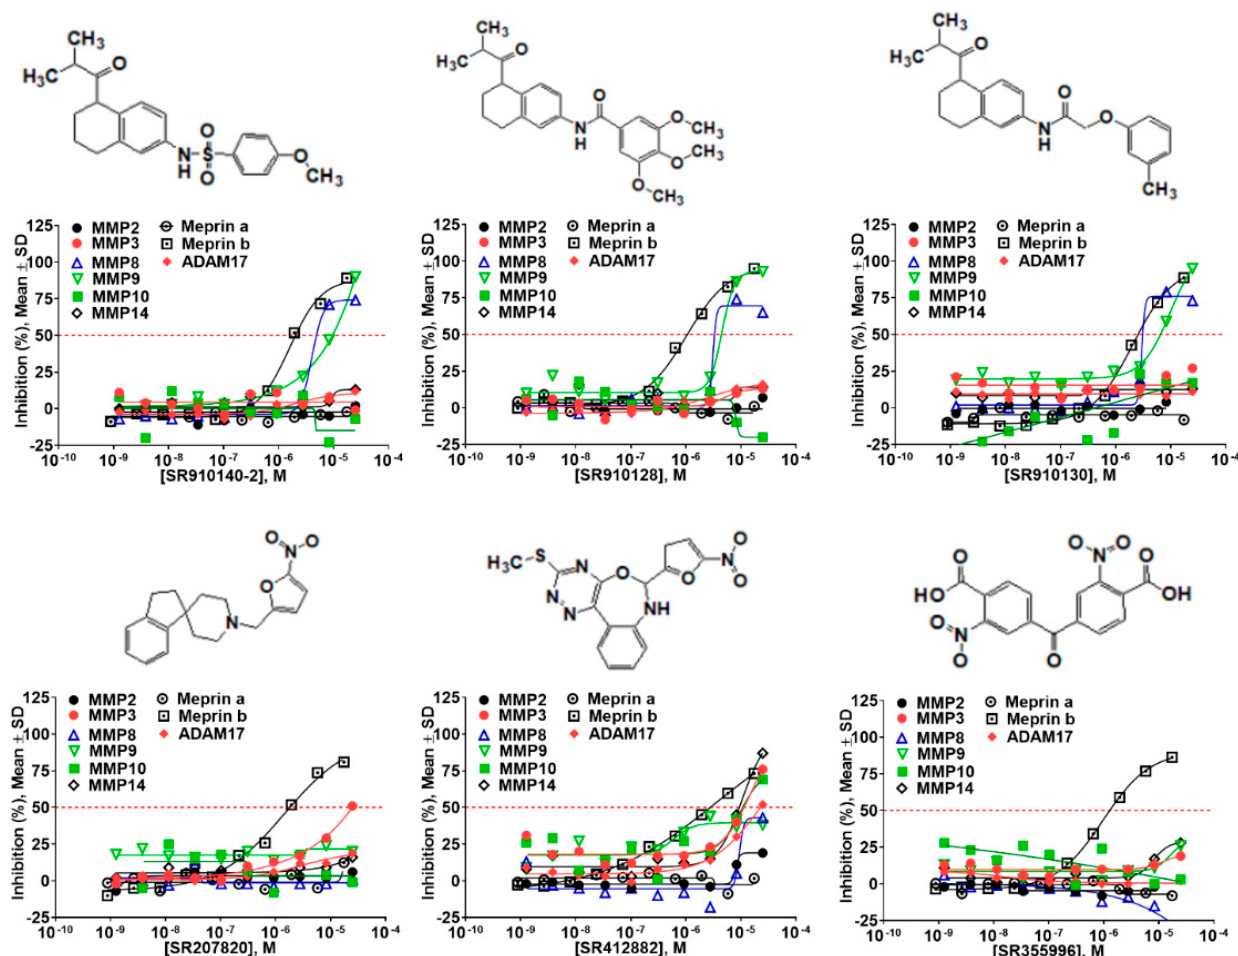
Figure 7. Results of concentration response studies of top potent and selective meprin β inhibitors.